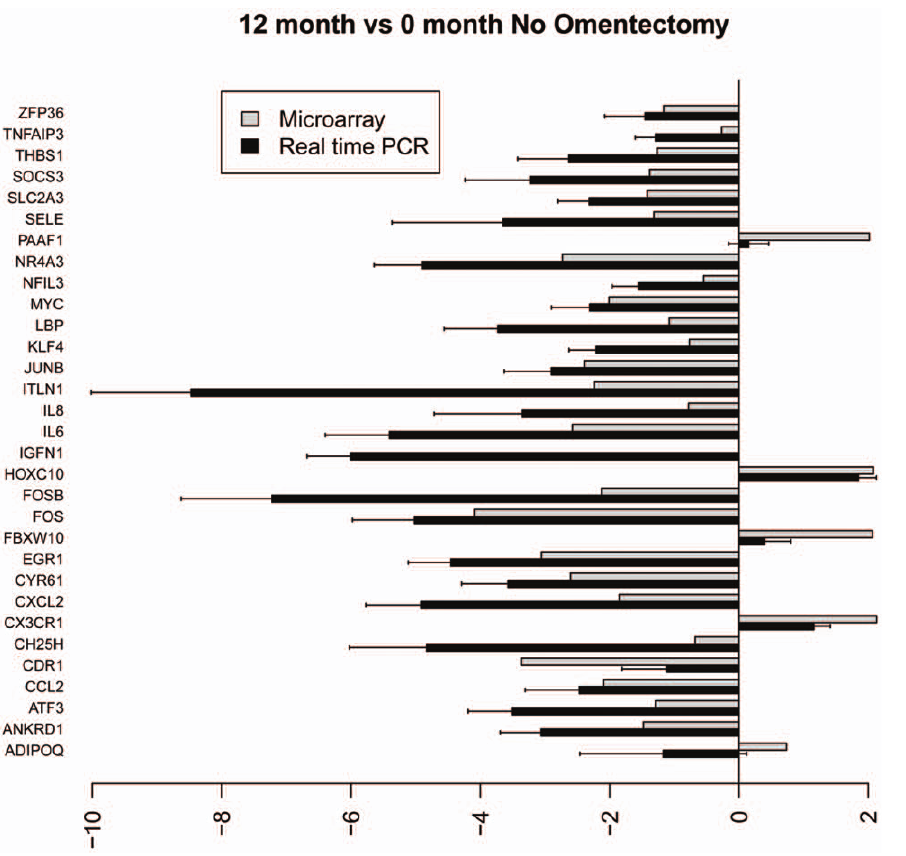
Figure 5. Bar graph illustrating the fold change of individual genes at 12 vs. 0 months without omentectomy as determined by microarray (grey) and TLDA profiling (black).